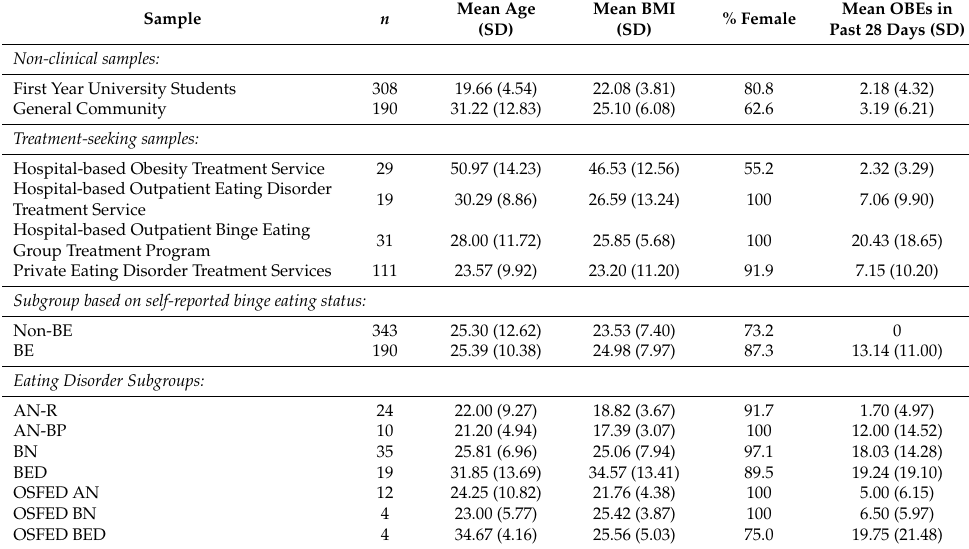
Table 1. Demographic Information for participant